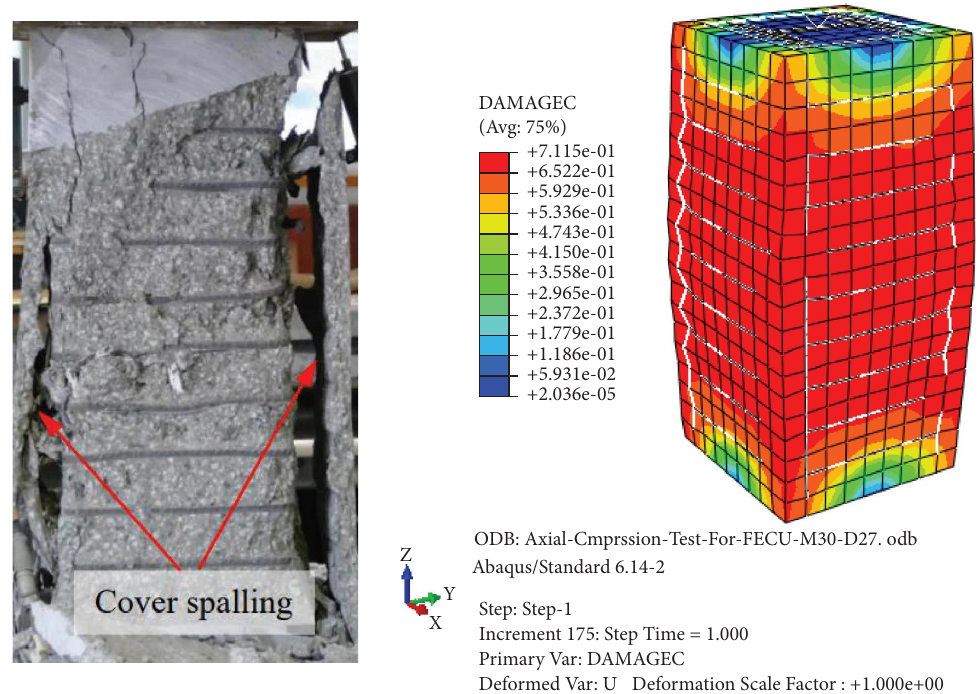
Figure 6: Concrete cover spalling of experimental and numerical column of